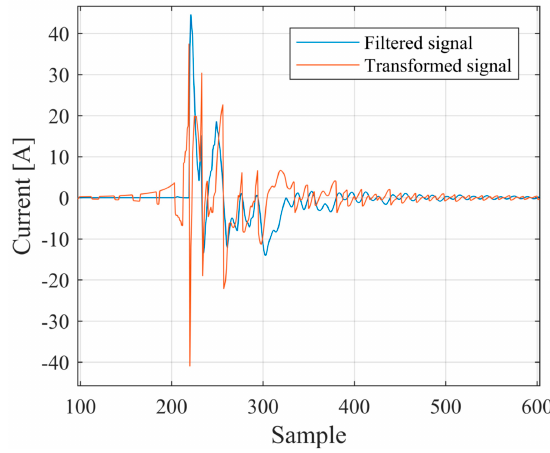
Figure 4. Filtered fault current and its Hilbert transform.